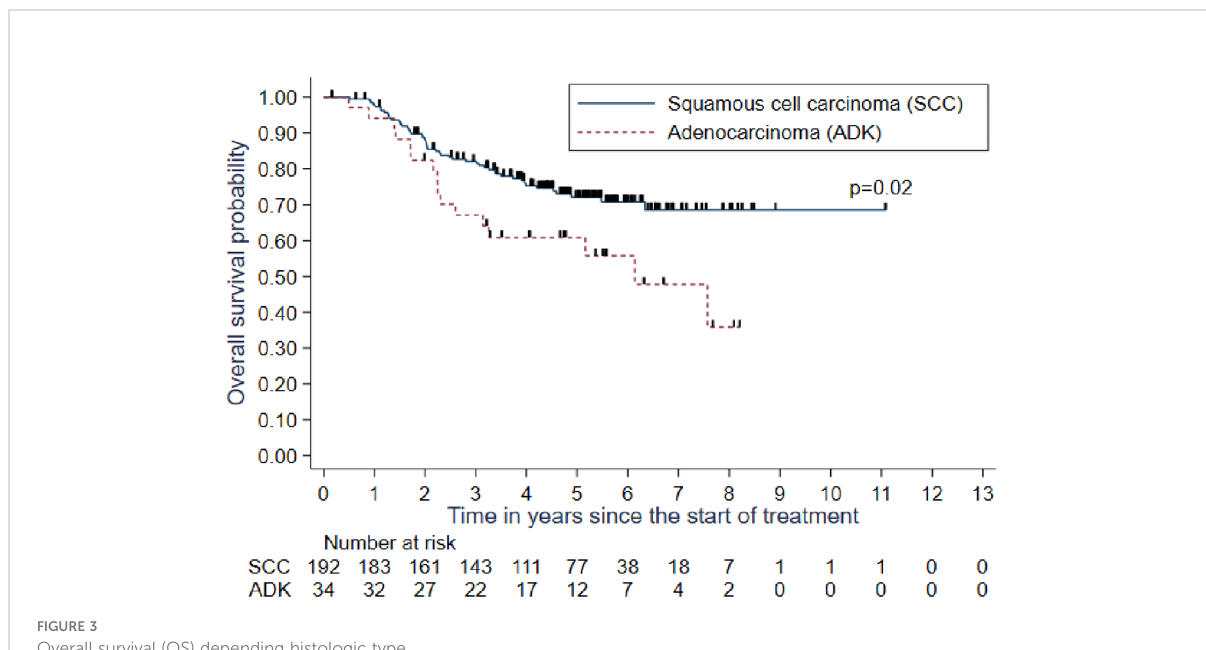
FIGURE 3 Overall survival (OS) depending histologic